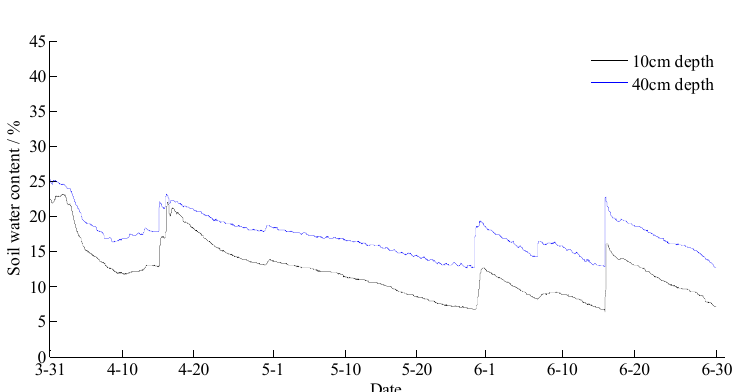
Figure 17. The curve of the air temperature in Hulun Buir.